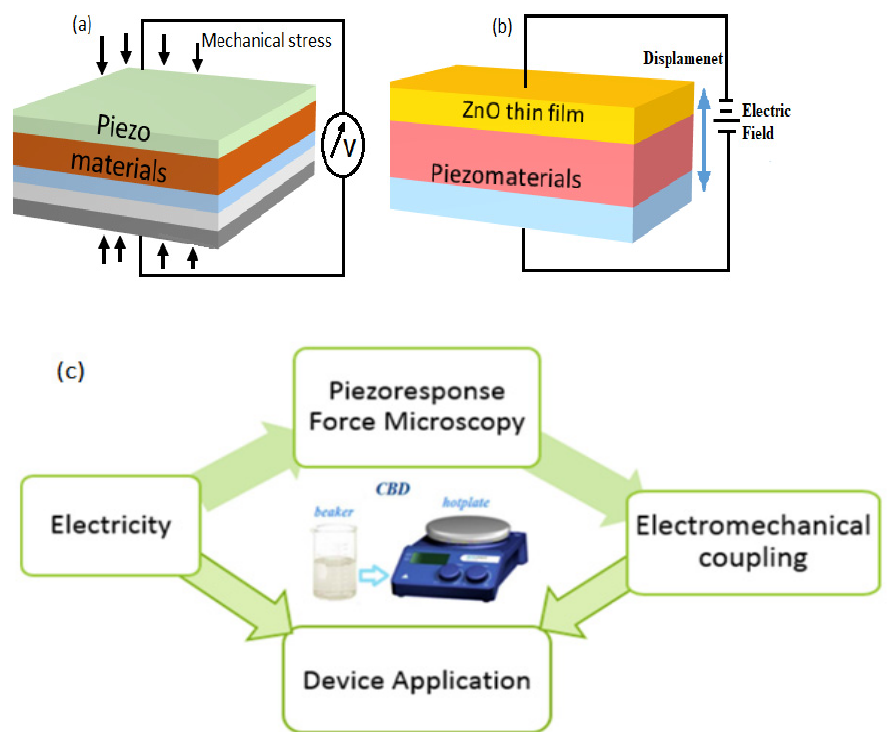
piezoelectric effect, (b) the inverse piezoelectric effect on piezoelectric materials, and (c) the entire method and principle of piezo response measurement on materials.